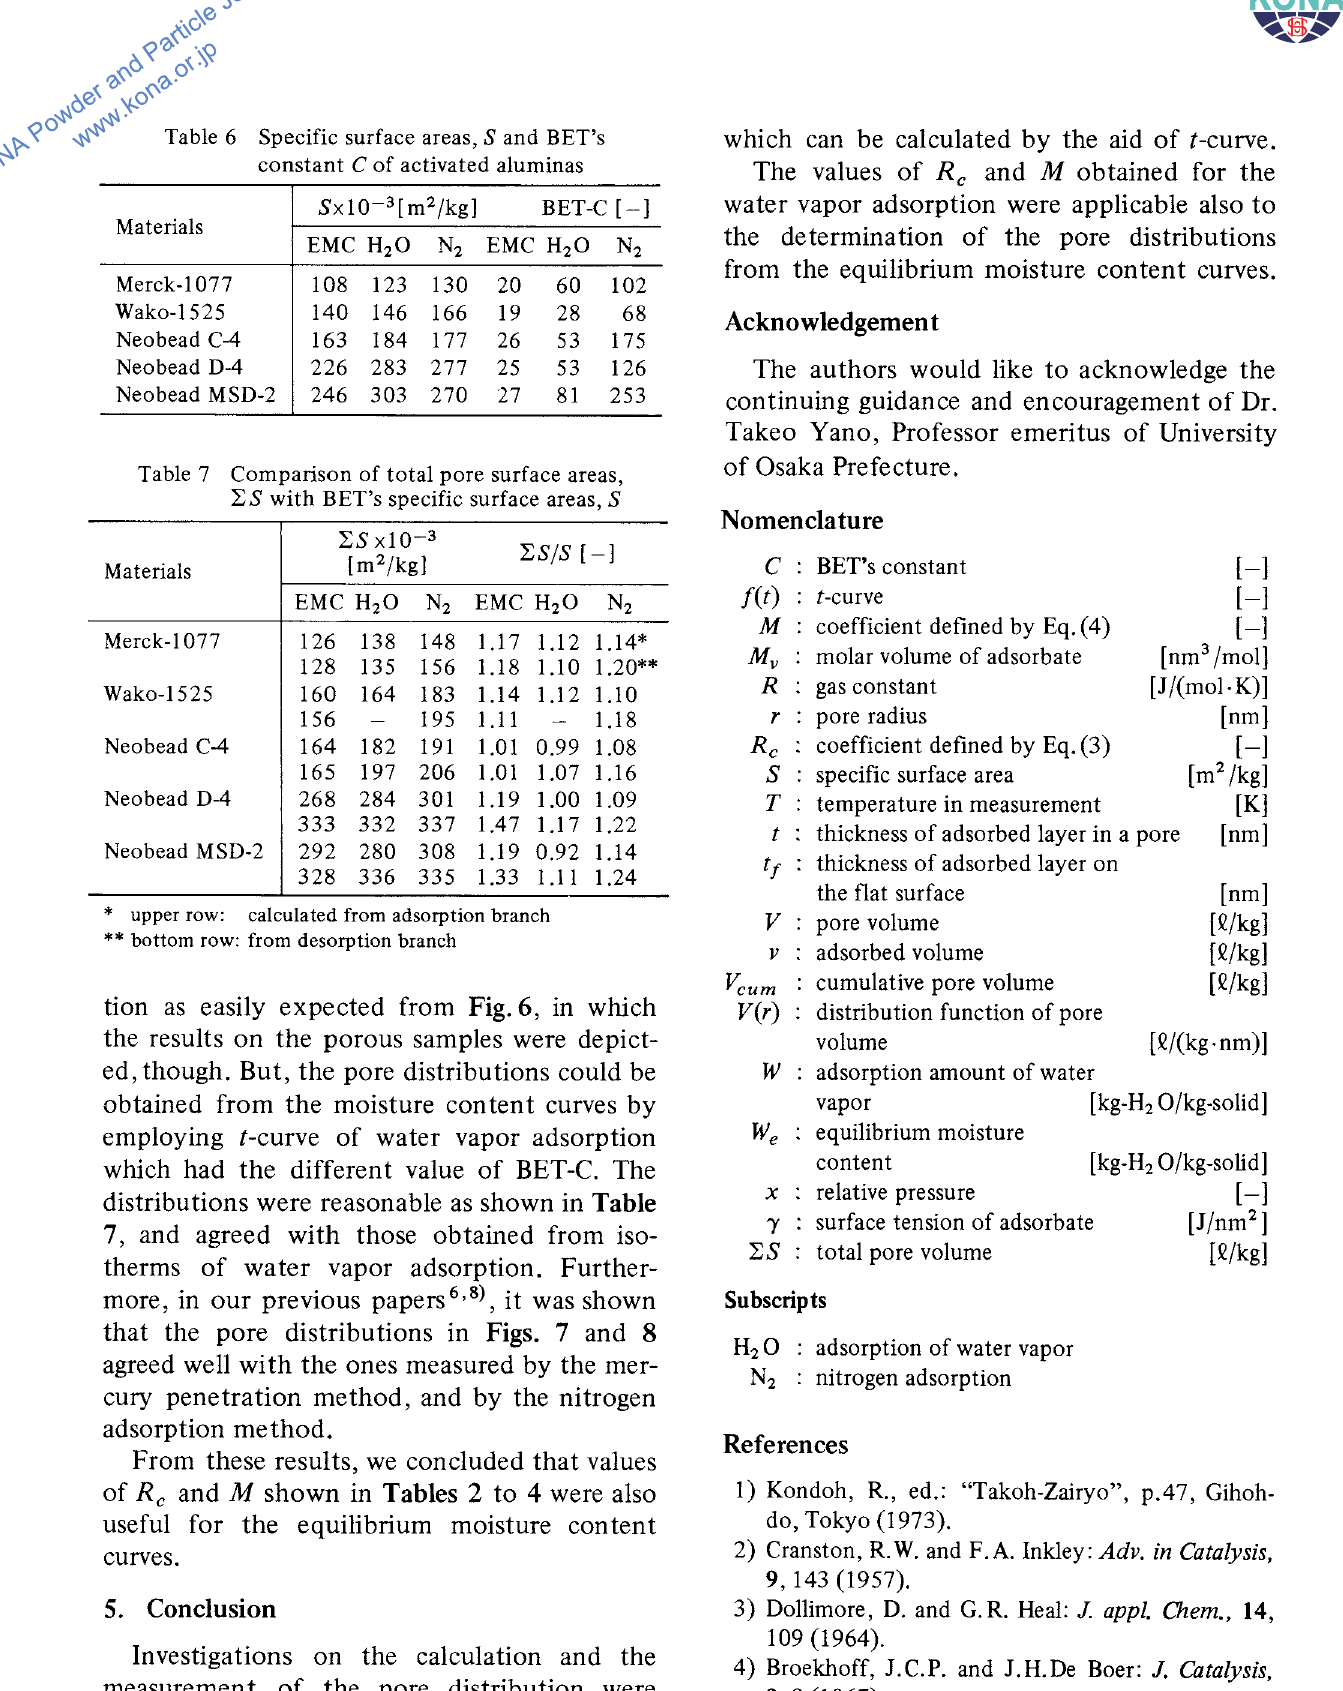
Table 6 Specific surface areas, S and BET's constant C of activated aluminas